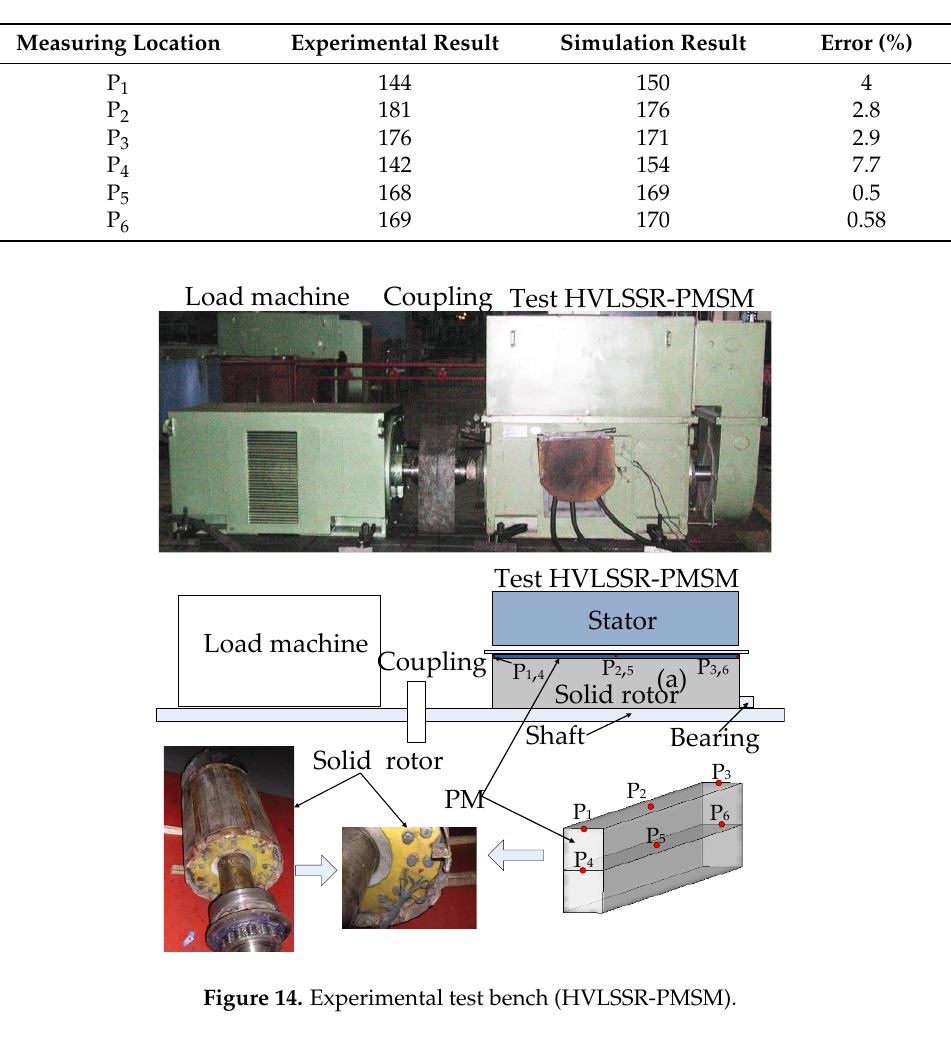
Table 5. Comparison of temperature data of permanent magnet.